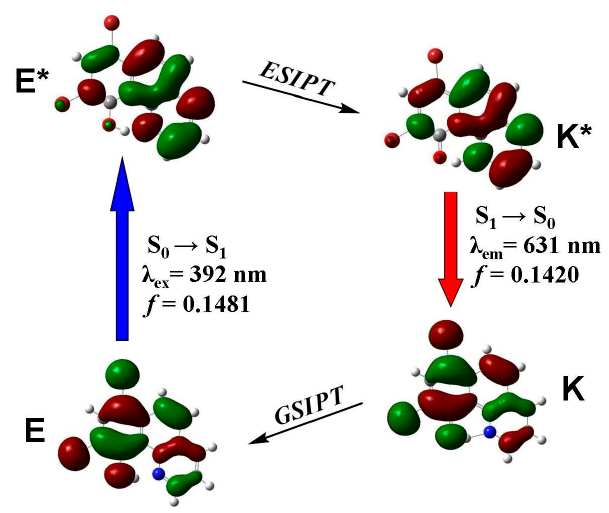
Figure 5. Selected frontier molecular orbitals involved in the excitation and emission of 1 .